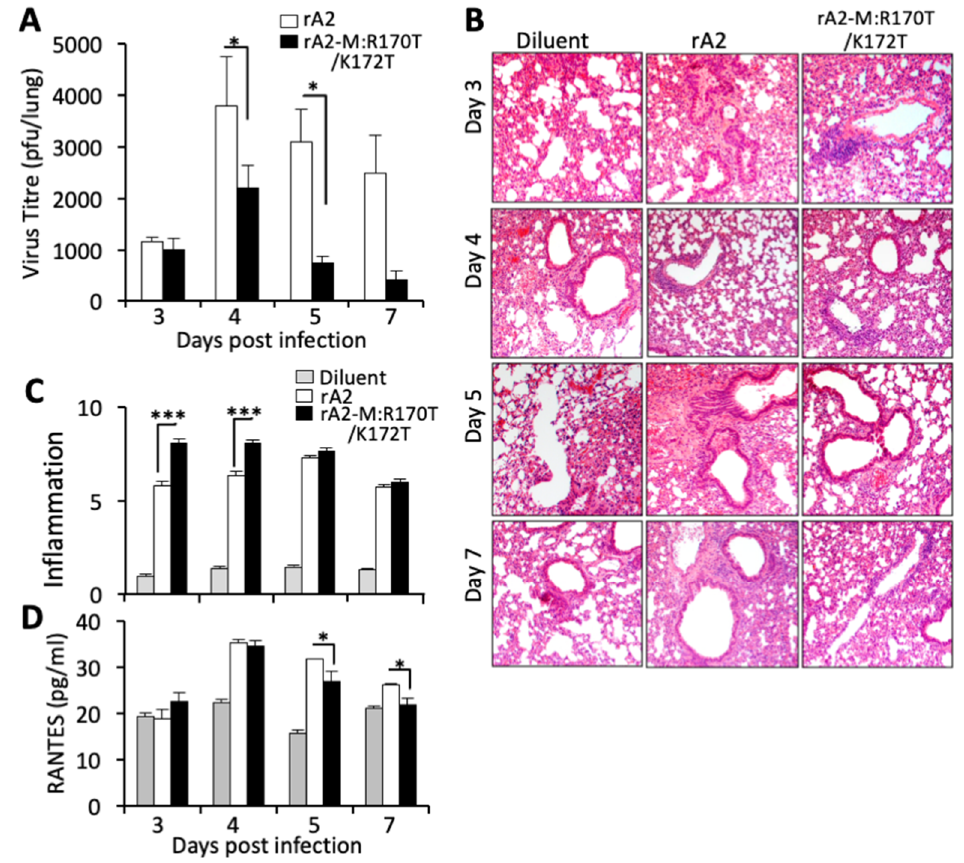
Figure 7. Recombinant RSV carrying R170T/K172T mutations in M induces higher inflammation and is cleared faster than wild type in a mouse model of RSV infection. BALB/c mice were inoculated with 50 µL of 2.5 × 10 5 pfu of rA2 or rA2-R170T/K172T or an equivalent volume of diluent on day 0. Five mice from each group were euthanized on the indicated days p.i., and samples collected for analysis. ( A ) One lung from each animal was put into 1 mL of diluent with steel beads and frozen at 80 °C. Lungs were subsequently homogenized in a Tissue-lyser, debris removed by centrifugation and the supernatant used immediately for plaque assay. Results represent the mean +/− SEM ( n = 5) for pfu/lung, representative of two separate experiments. White columns—rA2, black columns— rA2-R170T/K172T. * p < 0.05. ( B ) The second lung from each animal was fixed in formalin, embedded in paraffin, sectioned, and stained with haemotoxylin and eosin (H&E). Sections were imaged using a Leica DM750 microscope and the LAS software; five images were obtained at each of three different depths from each lung. Representative sections from each experimental group are shown, typical of two separate experiments. ( C ) Inflammation around bronchi was quantitated independently by two operators according to the schema described in Section 2.16 (0–9 scale [43]) using digital images such as those shown in ( A ). Quantitation was performed on multiple lung lobes from 3 different depths of sectioned tissue; results represent the mean + SEM ( n ≥ 50). Grey columns—diluent, white columns—rA2, black columns—rA2-R170T/D172T. *** p < 0.001. ( D ) Blood was collected by cardiac puncture. Systemic inflammation was determined by ELISA for RANTES as described. Results represent the mean +/− SEM ( n = 5). Grey columns—diluent, white columns—rA2, black col-